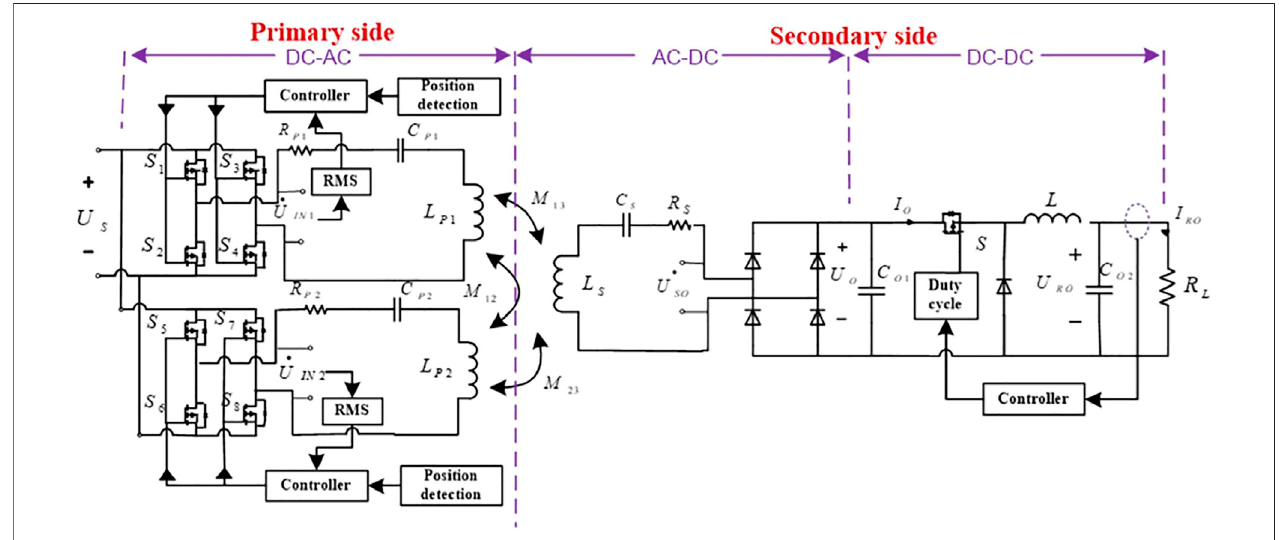
FIGURE 3 | Circuit topology of the sub-module in the WPT system.